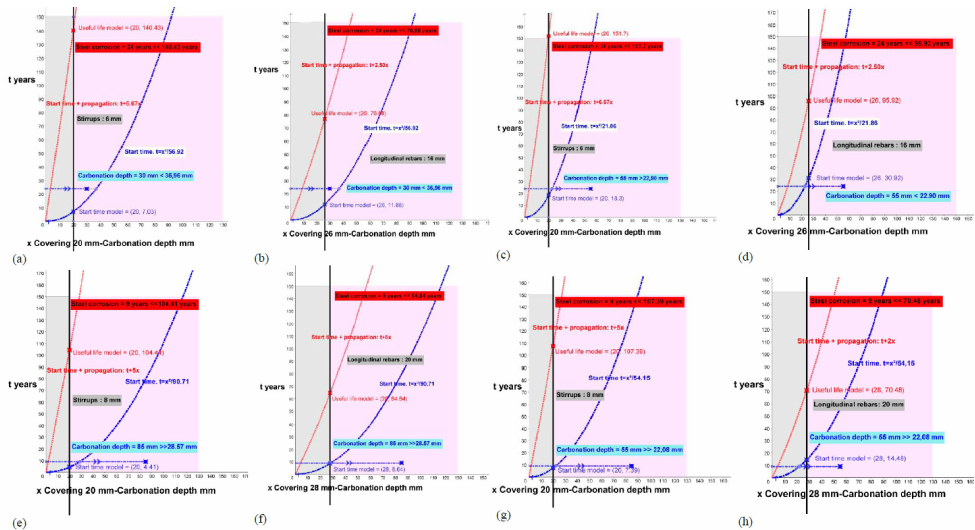
Figure 6. Start and propagation corrosion times in buildings 1D, 2G, 3T, 4T and 5T. ( a ) 1D_P8_Stirrups. ( b ) 1D_P8_ longitudinal rebars. ( c ) 1D_P16_Stirrups. ( d ) 1D_P16_ longitudinal rebars. ( e ) 2G_P1_ Stirrups. ( f ) 2G_P1_ longitudinal rebars. ( g ) 2G_P2_S Stirrups. ( h ) 2G_P2_ longitudinal